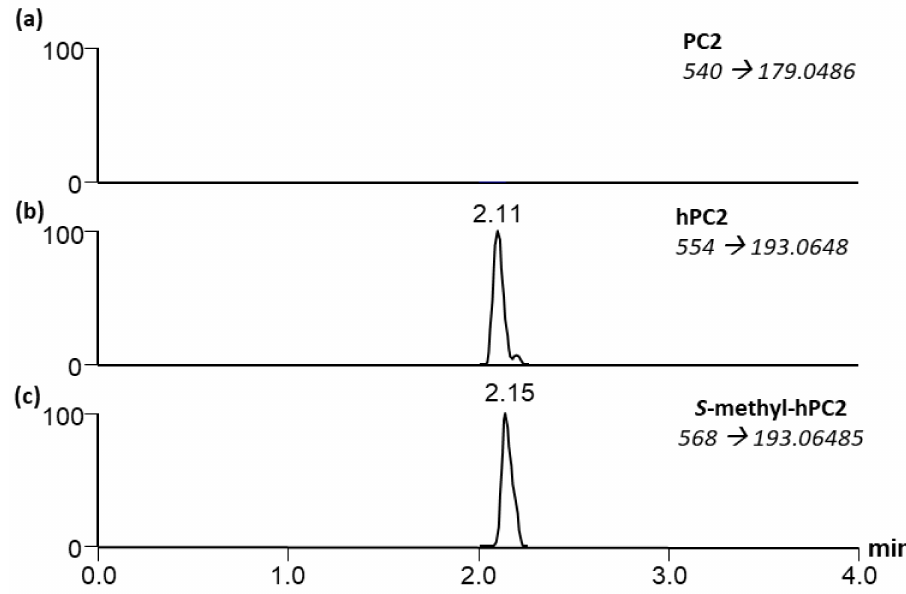
Figure 6. MS / MS chromatograms for monitoring ( a ) phytochelatin-2 (PC2); ( b ) homophytochelatin-2 (hPC2) and ( c ) S -methylhomophytochelatin-2 with a single S -methylcysteine ( S